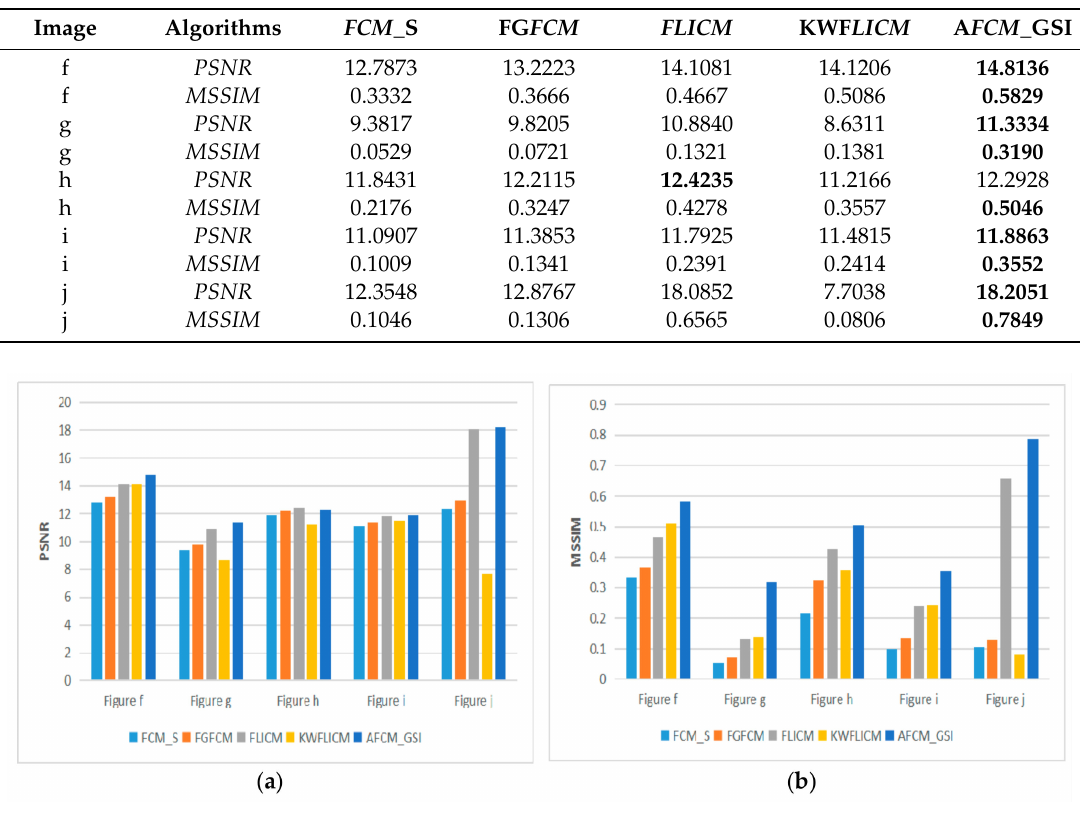
Figure 9. PSNR and MSSIM of five algorithms on noisy remote sensing images